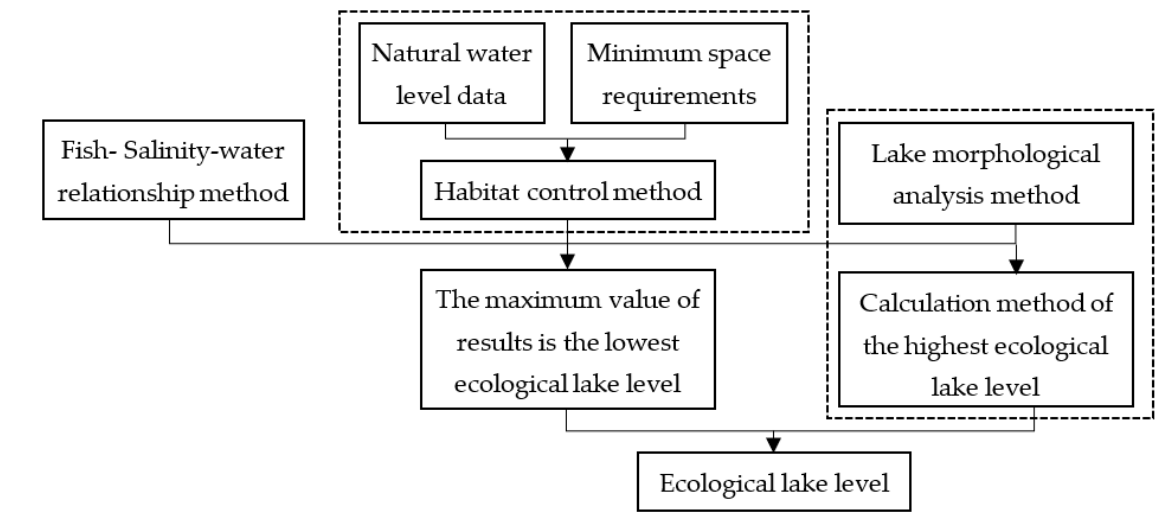
Figure 3. Flow chart of methods used to calculate ecological lake level.